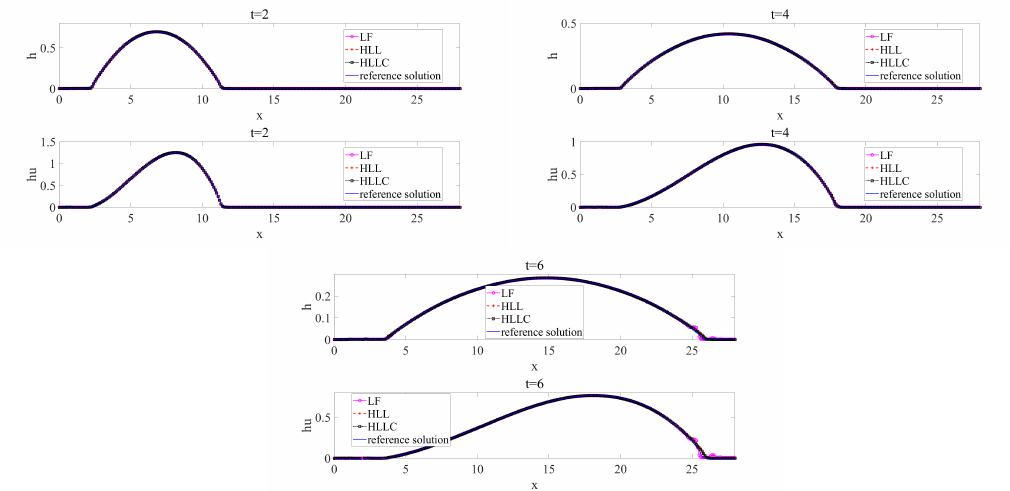
Figure 3. Depth and corresponding discharge hu profiles with WENO–LF, WENO–HLL, and WENO– HLLC fluxes at t =